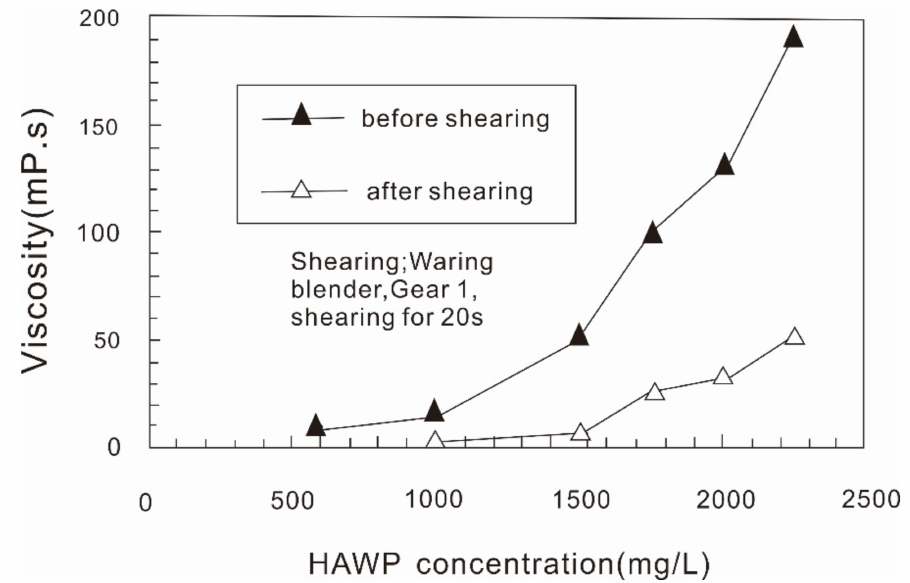
Figure 9. Viscosity–concentration curve under typical reservoir condition